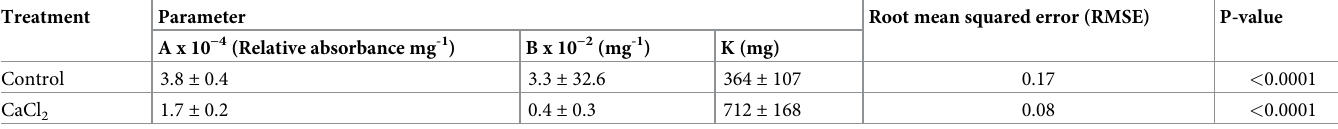
Table 1. Parameter estimates of the Goudriaan and Monteith [10] expo-linear regression model used to describe the relationship between anthocyanin leakage (absorbance) and water